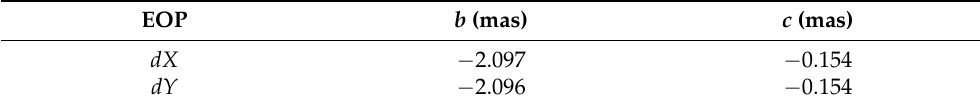
Table 5. Estimated coefficients of the power model relating precision and network volume.